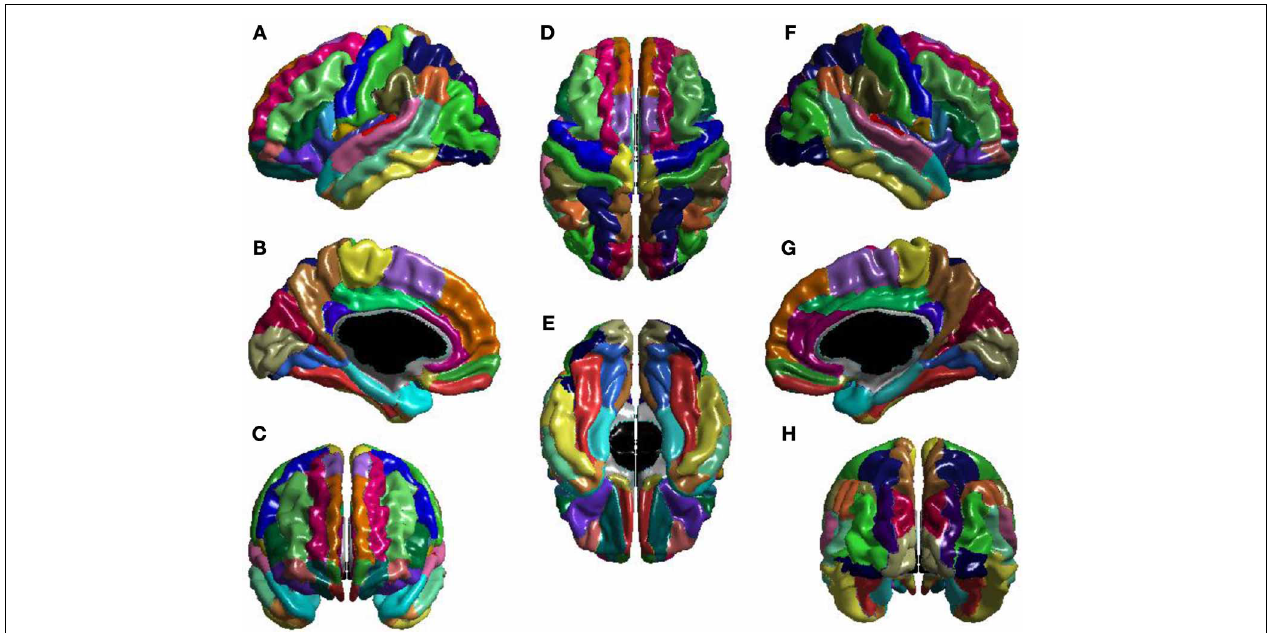
FIGURE 1 | The AAL atlas views: (A) left lateral, (B) left medial, (C) anterior, (D) superior, (E) inferior, (F) right lateral, (G) right medial, and (H) posterior. The regions are colored to identify region boundaries. Similarity of colors between spatially separated regions is